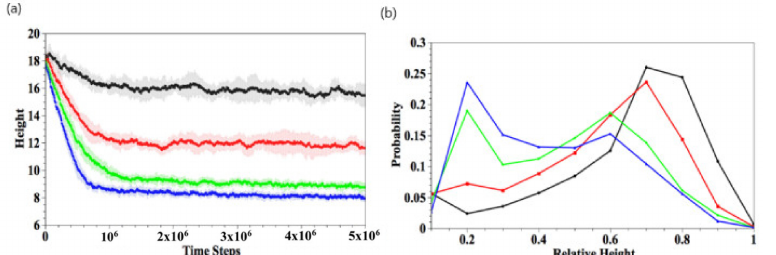
Figure 3. ( a ) Temporal evolutions of gel height. ( b ) Spatial distribution of bound dimers scaled by the gel height at t = 5 × 10 6 . Here, N dimer = 150 (black), 250 (red), 350 (green), and 450 (blue), respectively.